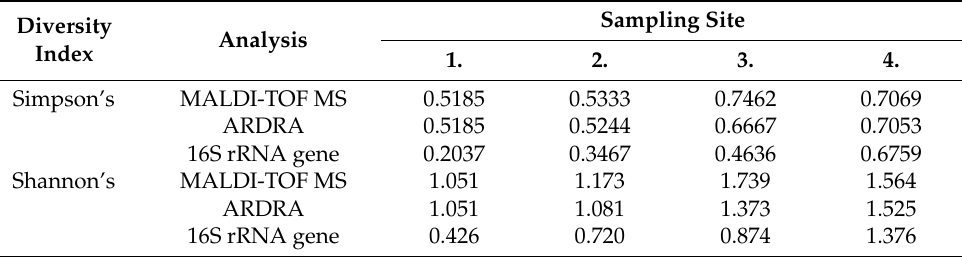
Table 4. Alpha diversity of Acinetobacter spp. population in different stages of the wastewater treatment process observed using different